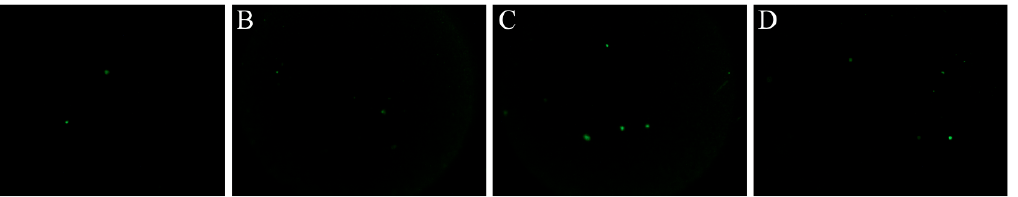
Figure 4. Comet assay of DNA extracted from V. parahaemolyticus ATCC 17802 from different treatments. ( A ) Untreated, ( B ) treated with 0.1 mg/mL of citral for 30 min, ( C ) treated with LED irradiation for 30 min, and ( D ) LED treatment combined with 0.1 mg/mL of citral for 30 min.